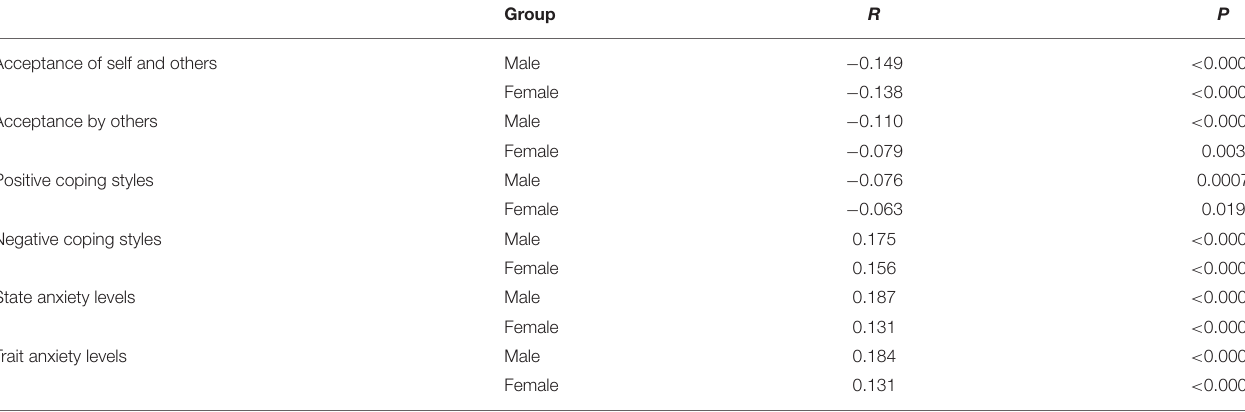
TABLE 1 | The correlations between CIAS scores and related factors in the male and female groups.